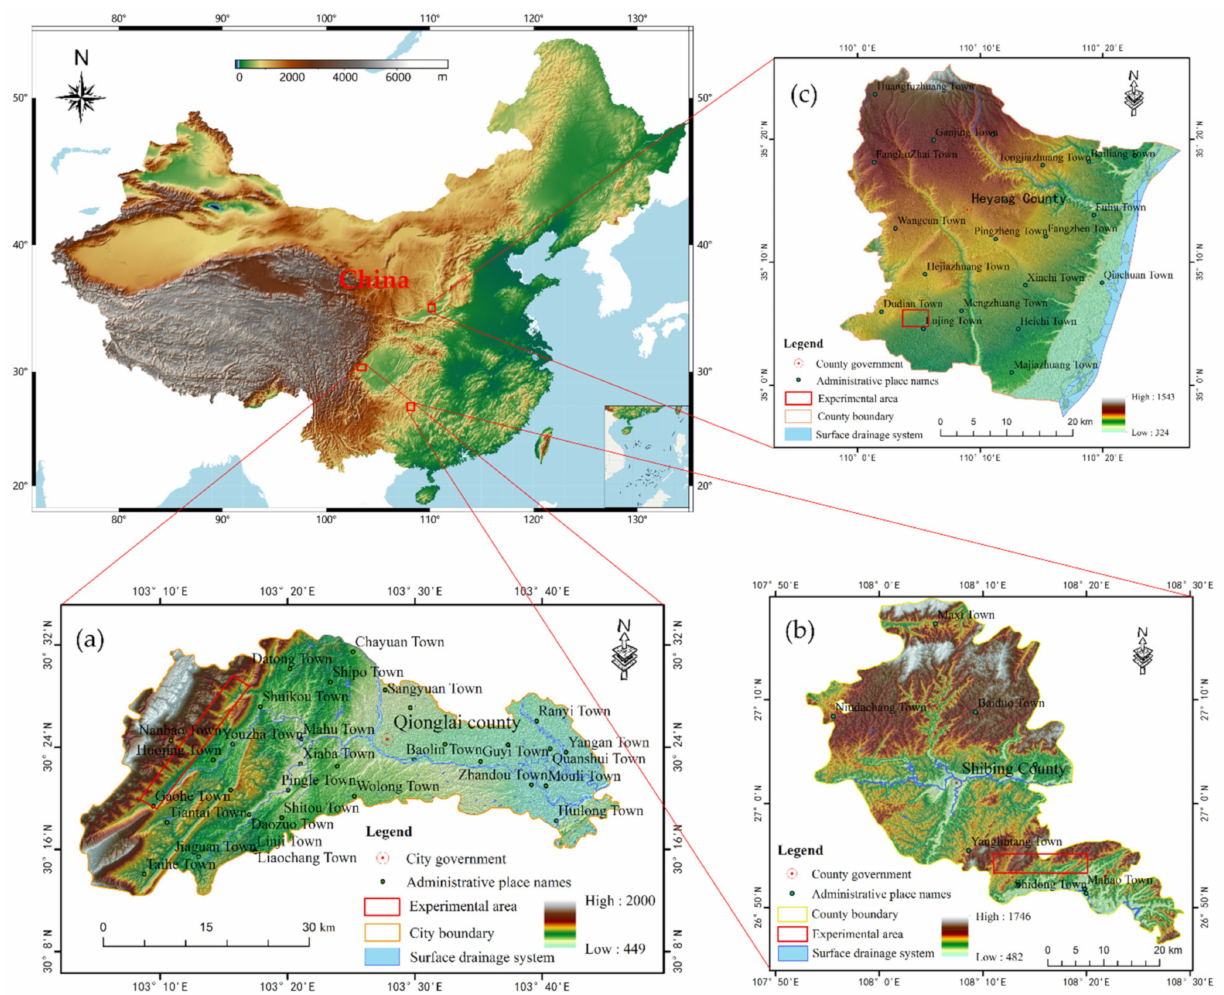
Figure 1. The three experimental areas for millimeter-wave InSAR data acquisition. ( a ) Qionglai area, ( b ) Shibing area, and ( c ) Heyang